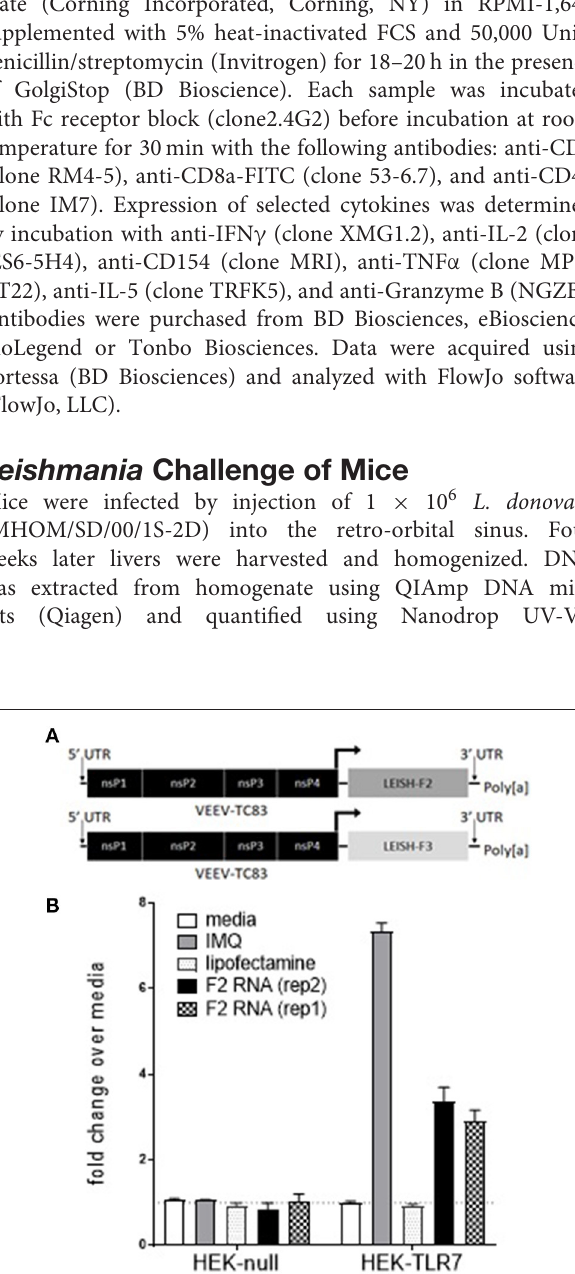
FIGURE 1 | F2-RNA replicons engage intracellular TLR7. In (A) , schematic depictions of the F2-RNA and F3 + -RNA replicons are shown. In (B) , HEK293-Blue cells and HEK293-Blue expressing human TLR7 were incubated with imquimod (IMQ), lipofectamine, or lipofectamine and two different production runs of F2 RNA vaccine construct (rep1 and rep2). Activation induced expression of SEAP was measured at OD650nm. Data were generated for each condition in triplicate and are shown as mean and SE fold-change over media alone